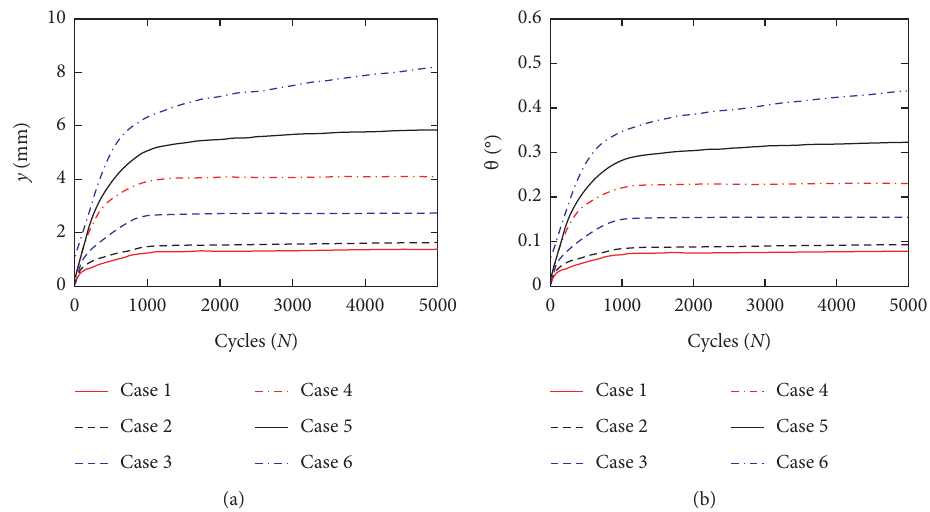
Figure 8: Variation in cumulative deformation of model pile top with the number of cycles: (a) cumulative displacement of pile top; (b) rotation angle of model pile top.